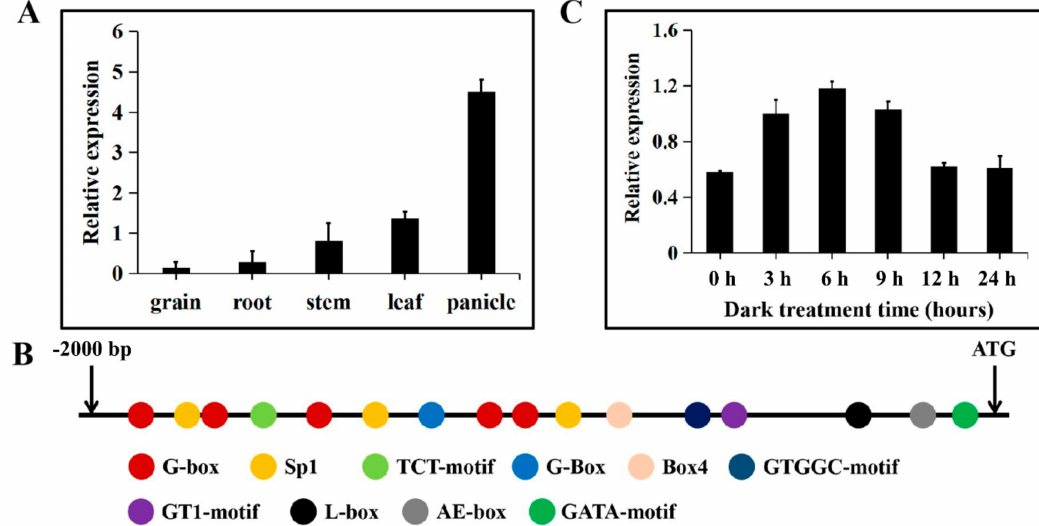
Figure4. Expressionpatternandpromotercis-regulatoryelementanalysisof TaTDRL .( A